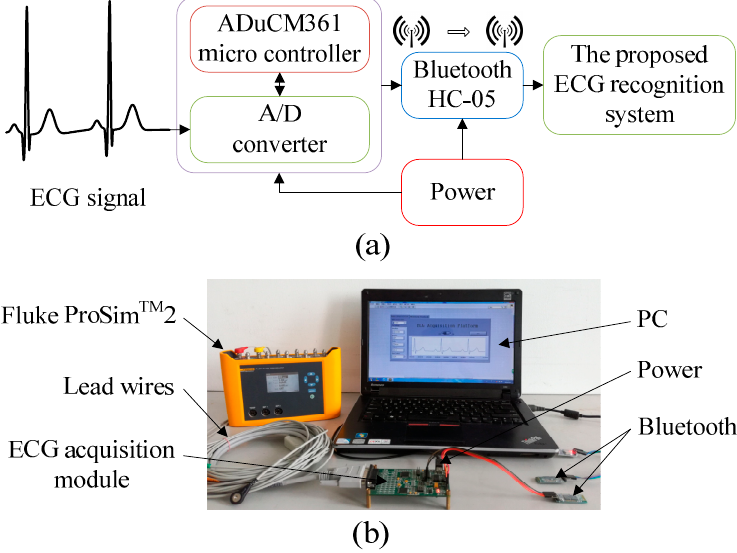
Figure 7. Diagrams of the ECG acquisition experimental platform. ( a ) Schematic of the experimental platform; and ( b ) Construction of the experimental platform.